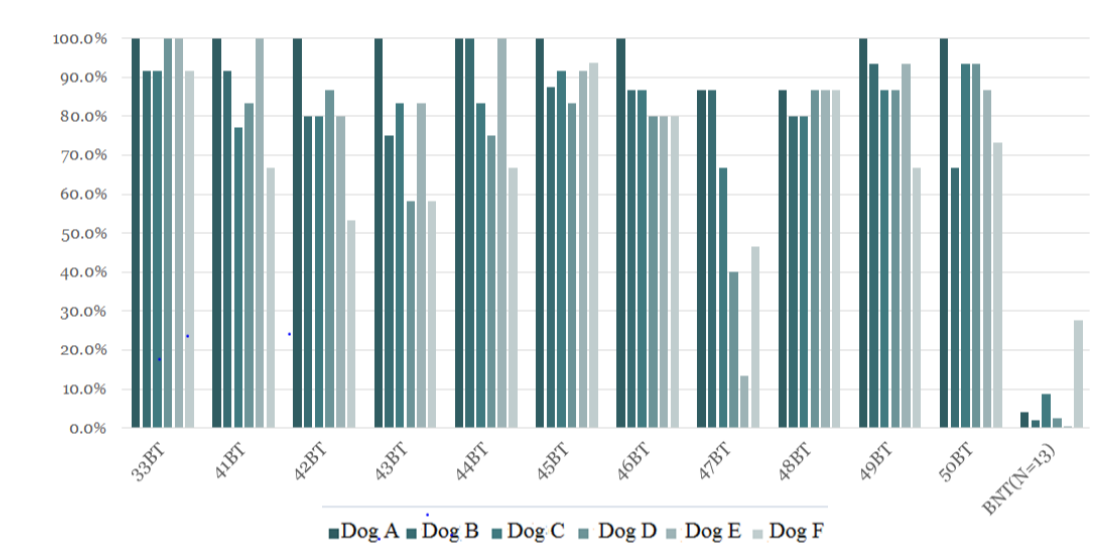
Figure 3. Individual canine response rates after using breathing target training. Individual canine response rates to exhaled breathing samples collected from patients with a confirmed diagnosis of lung cancer and from healthy controls after using breathing target training. Table 4. Training dogs using exhaled breathing target samples has a higher diagnostic rate for lung cancer than training dogs using lung cancer samples in lung cancer group.